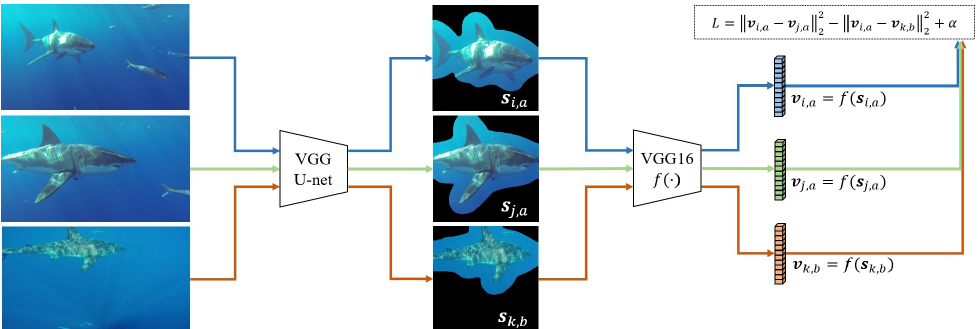
Figure 1. Illustration of the encoder architecture. The encoder includes VGG-UNet and